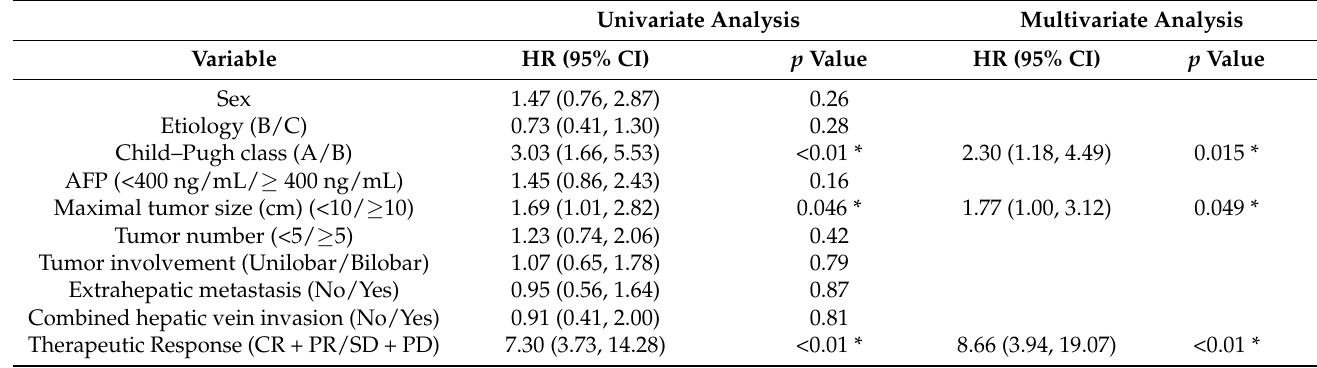
Table 3. Univariate and multivariate analysis of the hazard risk on OS of the 71 Vp4 patients. Univariate Analysis Multivariate Analysis